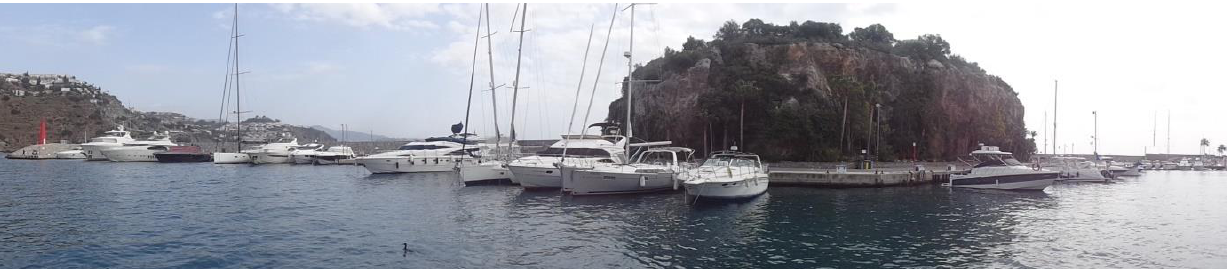
Figure 4. View of the marina